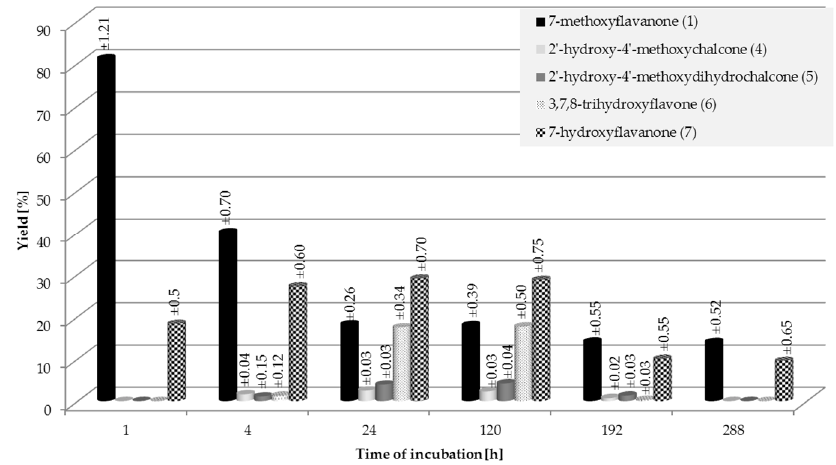
Figure 1. Biotransformation of 7-methoxyflavanone ( 1 ) in S. maltophilia KB2 culture; the yield (%) of the products was determined by HPLC.